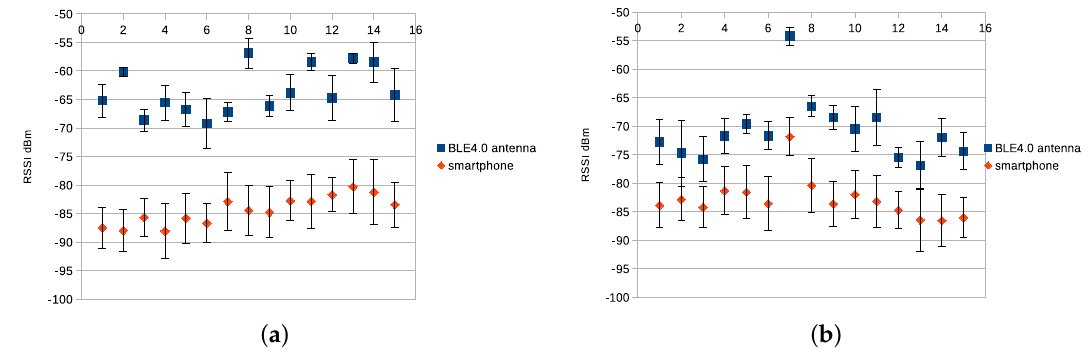
Figure 4. RSSI (dBm) for BLE4.0 Antenna and smartphone with transmission power Tx = 0x04 for each sector (1.15) of our environment. ( a ) for Be07; ( b ) for